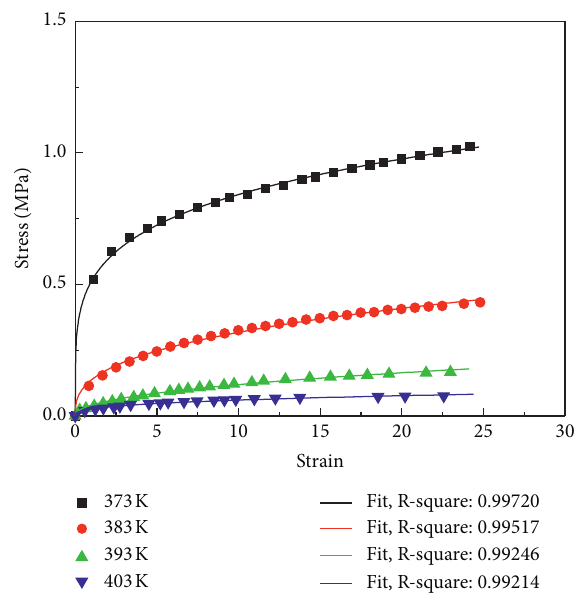
Figure 8: Tensile data of ABS at different temperature (above glass transition